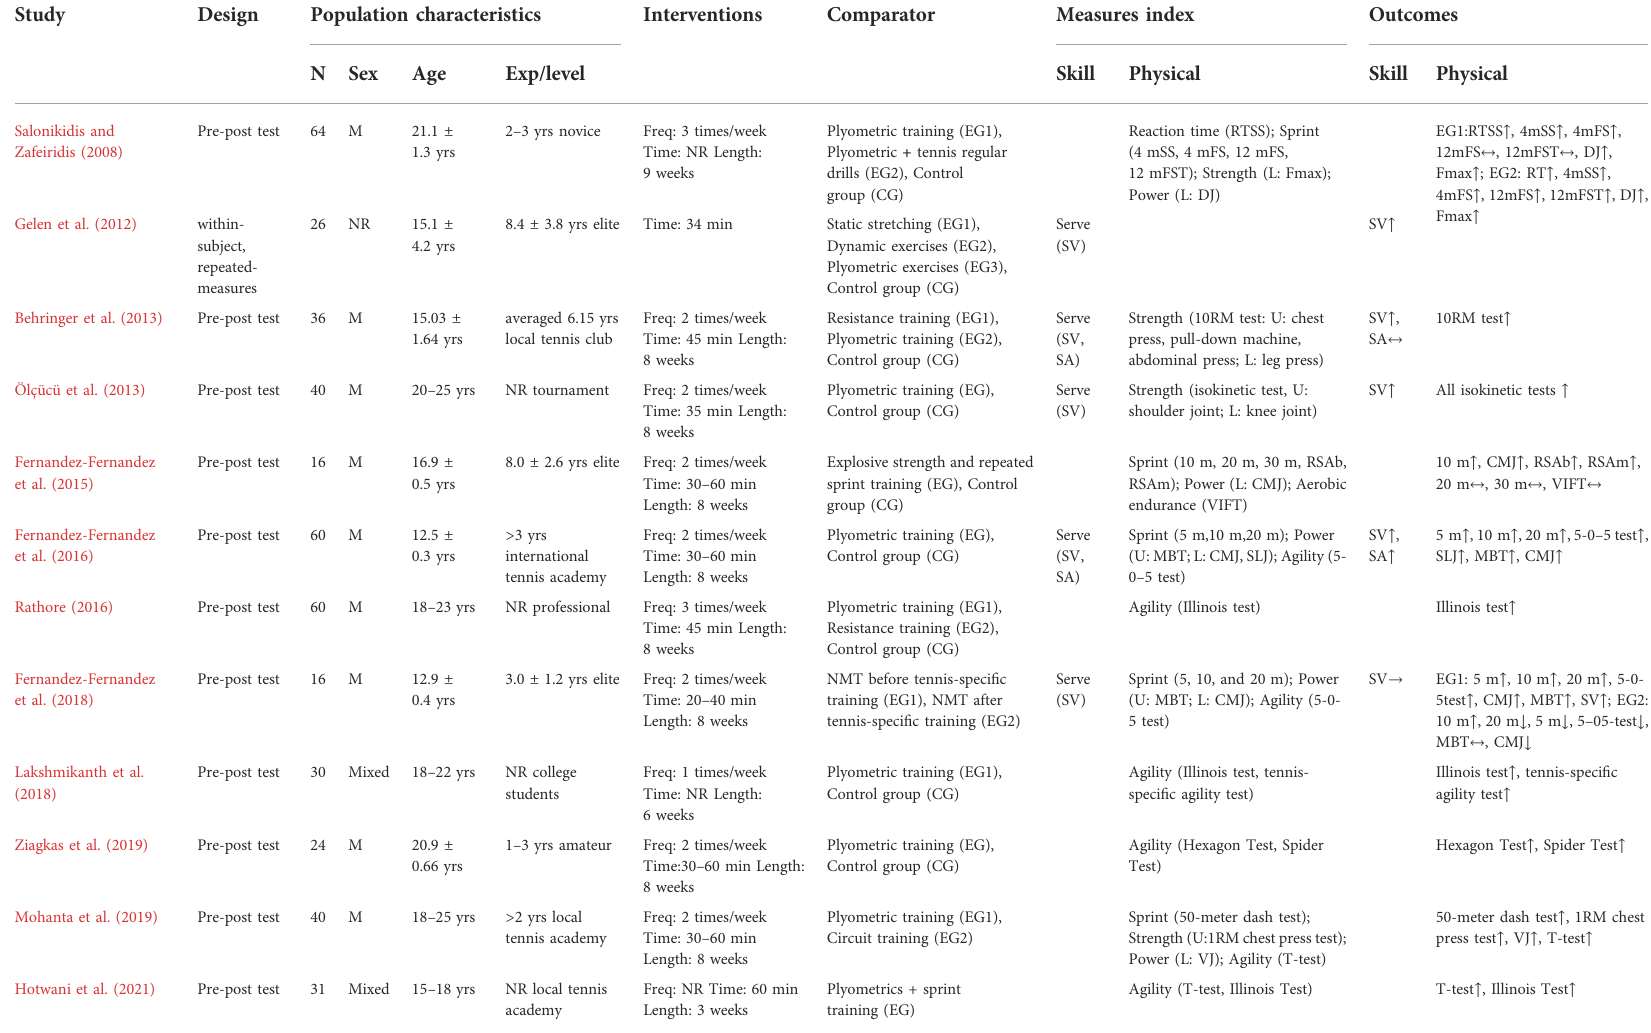
TABLE 2 Characteristics of the studies examined in the present